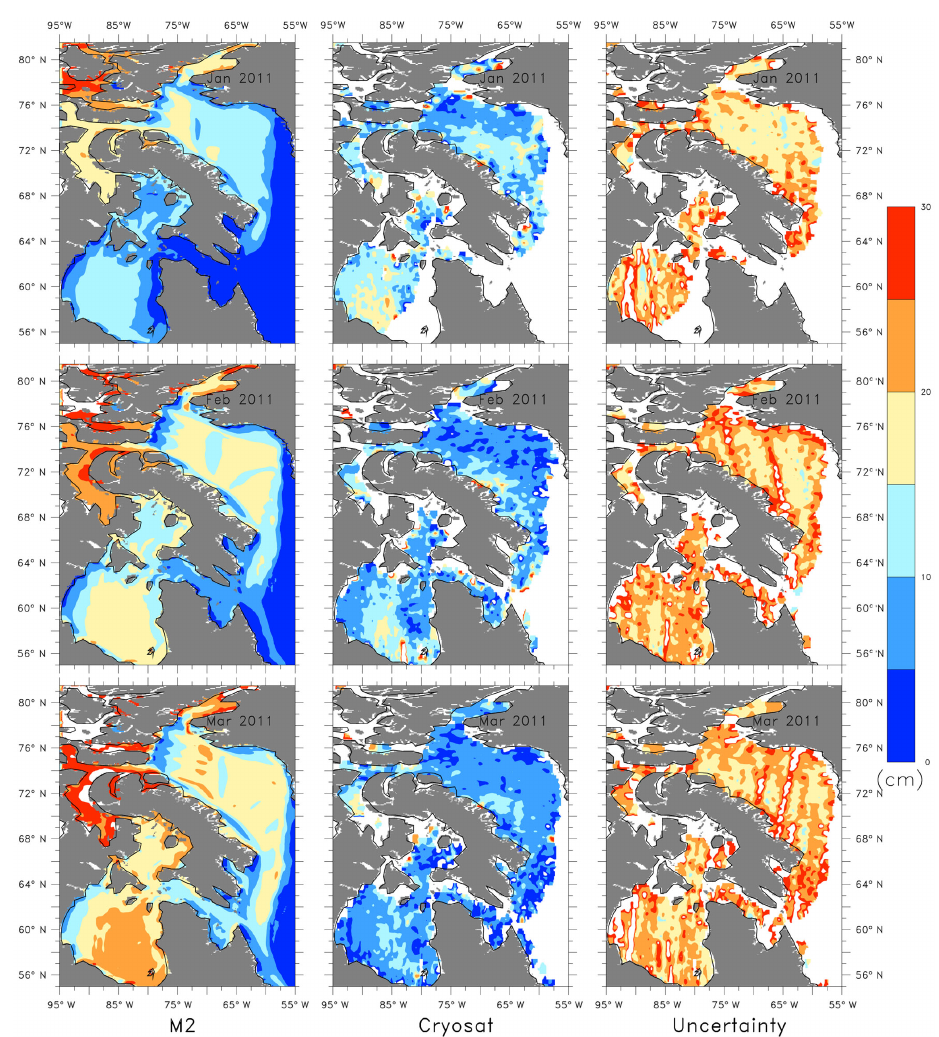
Figure 18. The freeboard from model M2, CryoSat-2 and the uncertainty in the observations for January, February and March